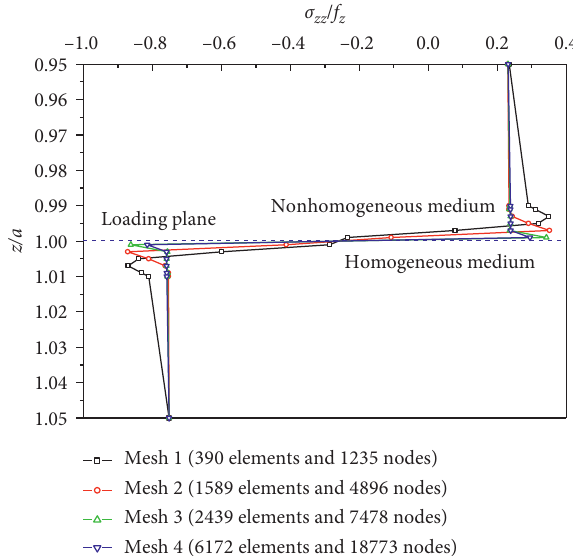
Figure 6: Variations of σ zz at the points close to the loading plane for different